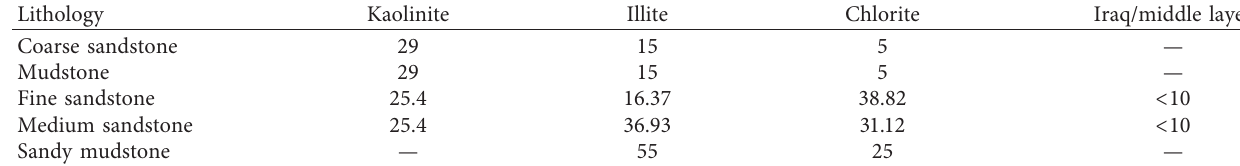
Table 1: The components of the shallow-buried